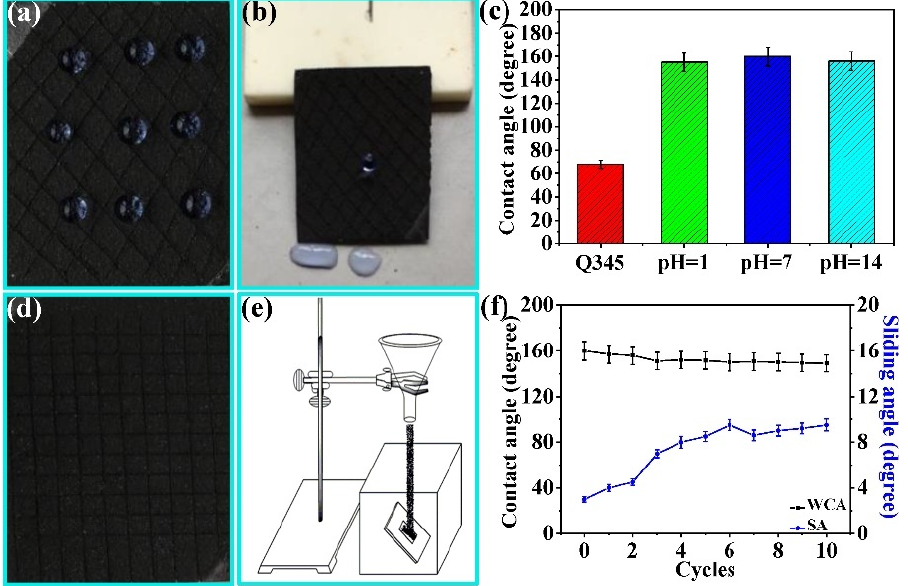
Figure 7. The WCA ( a ) and SA ( b ) of the CSC coating after scraping damage. ( c ) The WCA of Q345 and surface wettability of the CSC coatings after soaking in different pH solutions for 1 h. ( d ) Surface morphology of the CSC coating after the grid test. ( e ) Schematic diagram of the sand-washing device. ( f ) Variations in the WCA and SA of the CSC coating at different sand washing cycles.